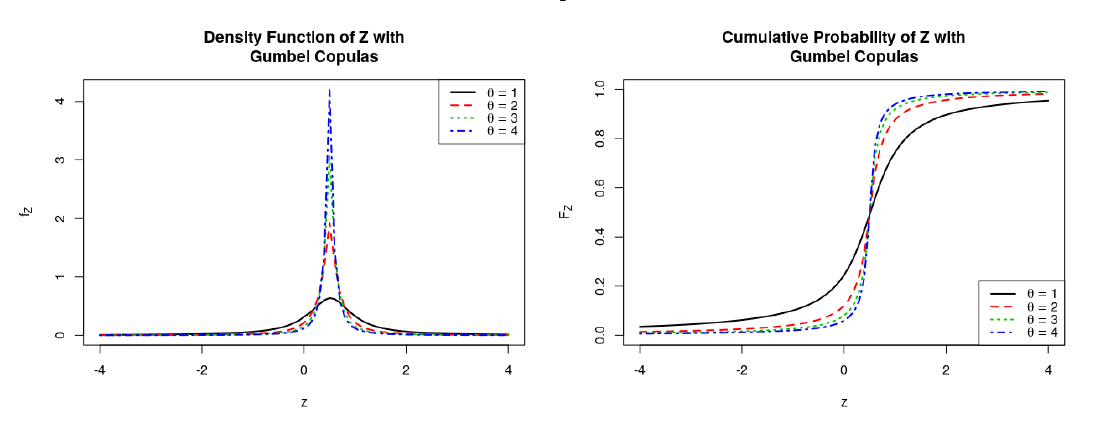
, where ( X 1 , X 2 ) follows Gumbel Copulas. X 2